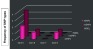
Distribution of TP53 coding synonymous SNPs (sSNPs), coding non-synonymous SNPs (nsSNPs) and INDEL through exon 5–8 in P53 gene.